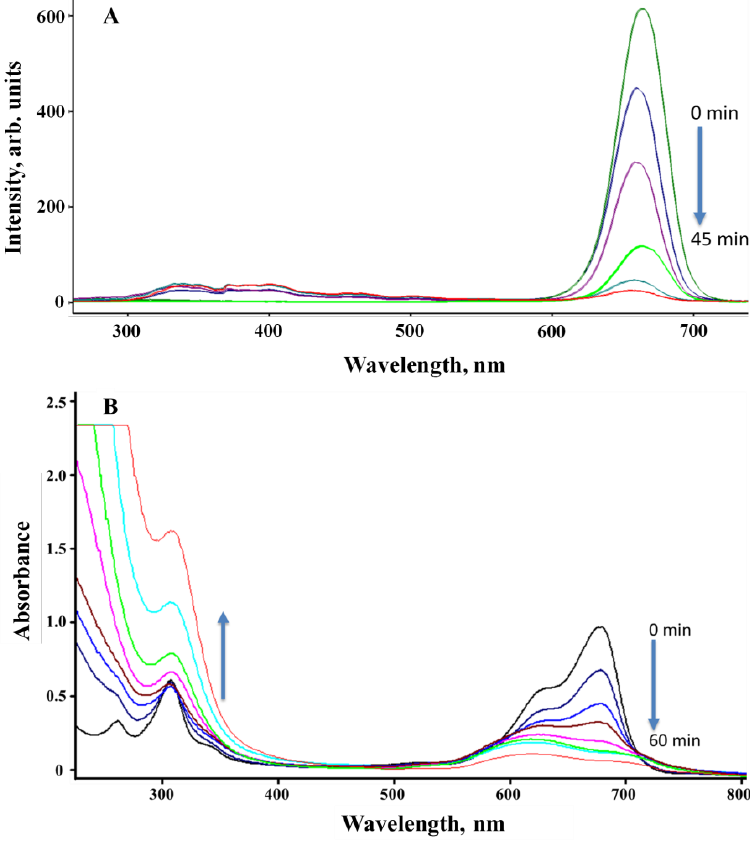
Figure 11. MB irradiated with 75 W LED white and 302 UV lights: ( A ) The SSLS of MB in the presence of Ti − Mo NC irradiated with 302 nm light for various times; ( B ) UV − Vis spectra of the MB/Ti − Mo NC irradiated with 302 nm UV for various times; and ( C ) pho- todegradation profile of MB alone irradiated 75 W LED (a) and 302 nm (b) lights along with the MB/Ti − Mo NC irradiated with LED light (c) and 302 nm UV (d).